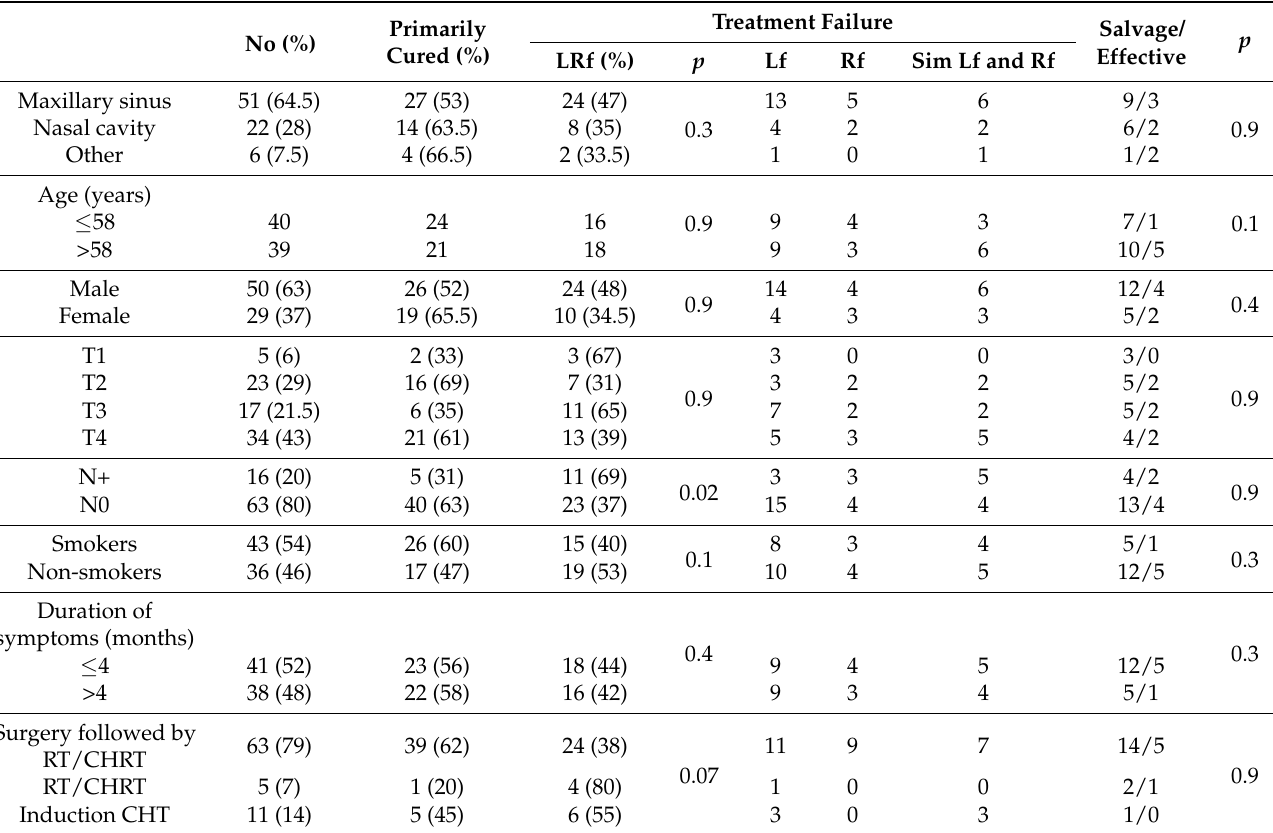
Table 1. The clinical characteristics of patients and the results of primary and salvage treatment accord- ing to selected clinical parameters. LRf—locoregional failure, Lf—local failure, Rf—regional failure, Sim—simultaneously, RT—radiotherapy, CHT—chemotherapy, and